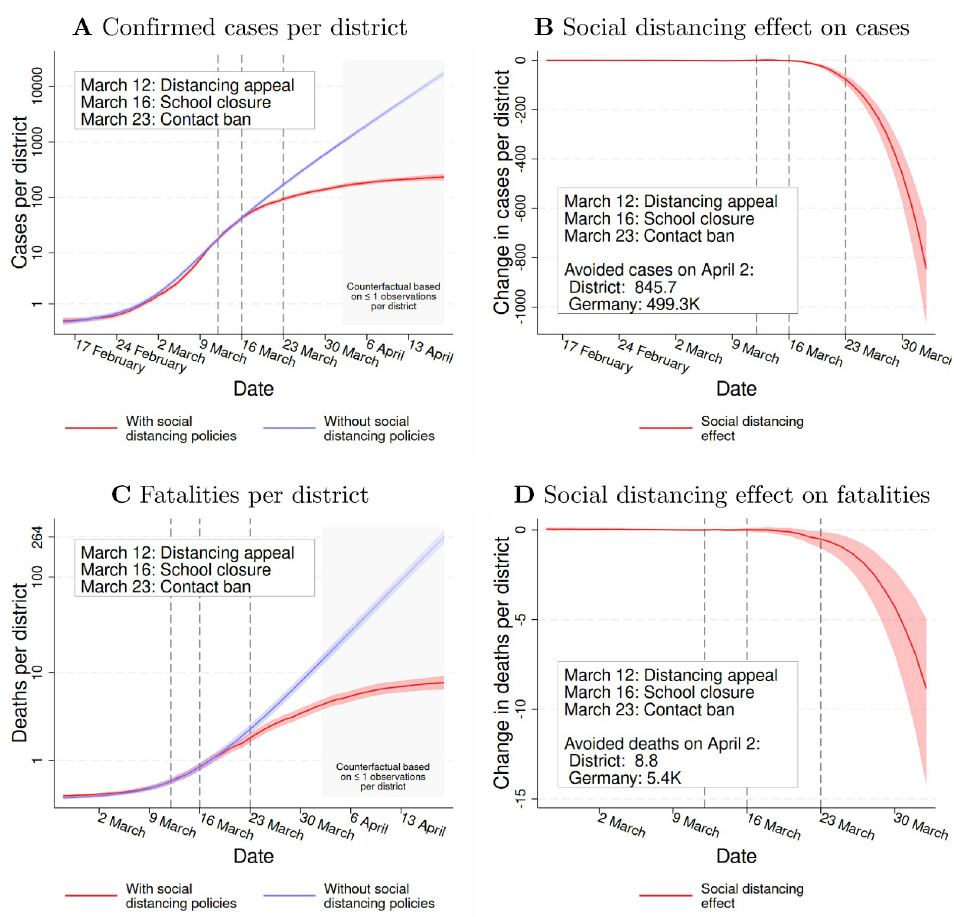
Fig 4. The social distancing effect on cases and fatalities. Notes : Fig 4A and 4B show how social distancing policies affect confirmed COVID-19 cases; Fig 4C and 4D show how the policies affected fatalities related to COVID-19. More specifically, Fig 4A demonstrates the development of cases in the realized world with SD policies (red line) and in the counterfactual world without SD policies (blue line). It shows average cases per district, using a logarithmic scale. Fig 4B presents the implied social distancing effect on cases using a linear scale. Fig 4C presents the development of fatalities in the realized world with (red line) and in the counterfactual world without (blue line) SD policies. Fig 4D presents the social distancing effect on fatalities. The three vertical lines mark the Chancellor’s appeal for social distancing (March 12), the nationwide school closures (March 16), and the nationwide contact bans (March 23). The dashed lines represent 95% confidence intervals based on district-level-clustered standard